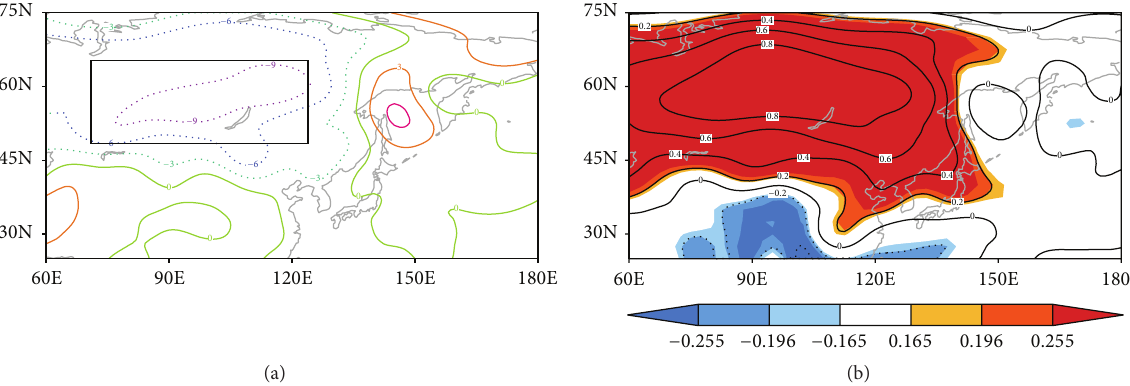
Figure 2: (a) The difference between the Asian winter temperature field at 1000hPa level: black box areas are key area; (b) correlation coefficient between winter temperature field at 1000 hPa level and AWH